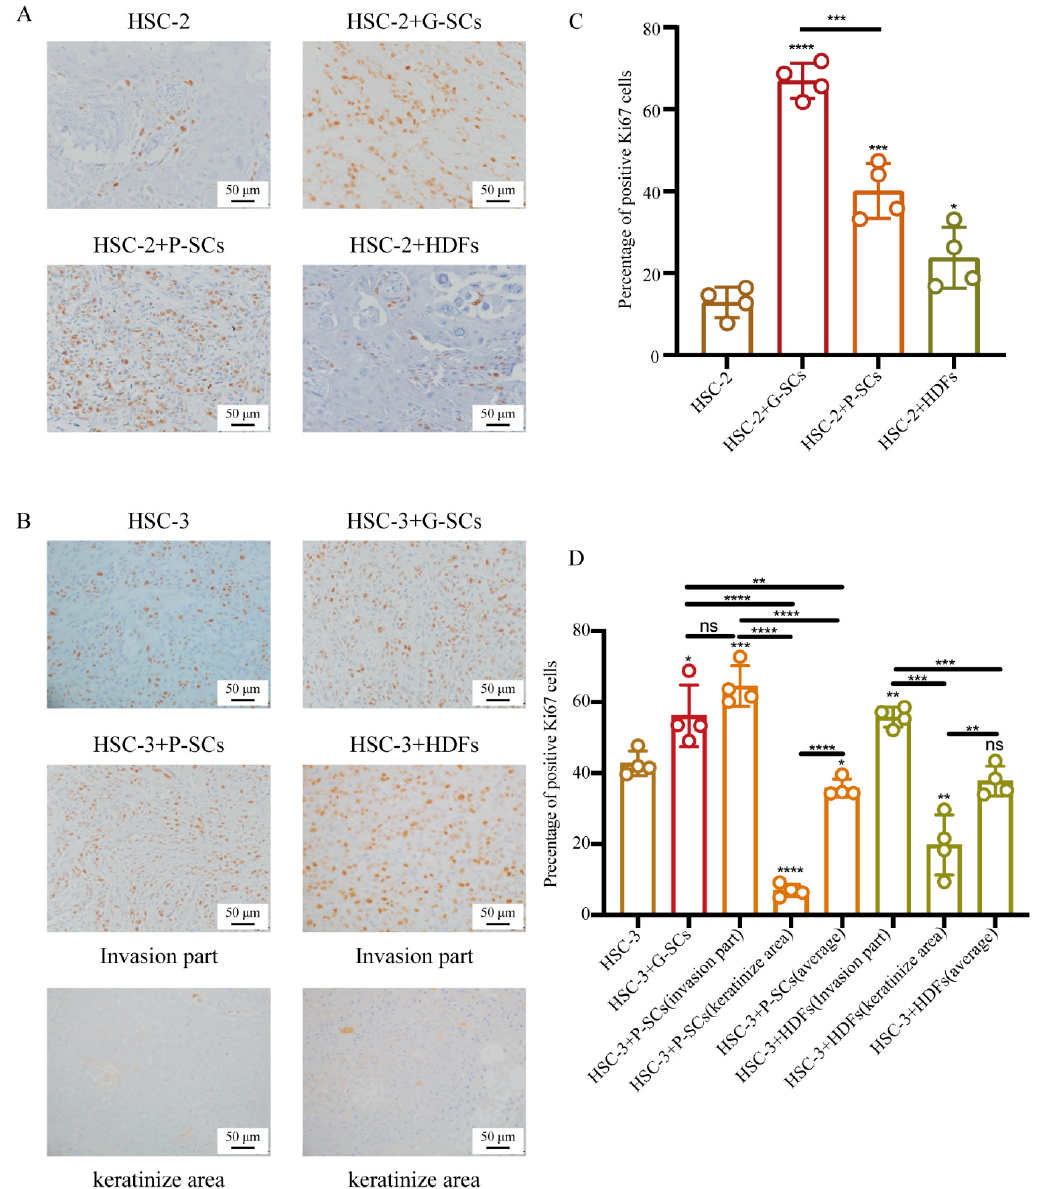
Figure 7. G-SCs and P-SCs influenced the proliferation of OSCC in vivo. ( A , B ) Ki-67 IHC staining was performed to examine the effect of G-SCs and P-SCs on the proliferation of HSC-2 ( A ) and HSC-3 ( B ) in vivo. ( C , D ) Quantification of Ki-67 positive cells in different groups of HSC-2 ( C ) and HSC-3 ( D ). Data are shown as the mean ± s.d. (s.d., standard deviation), n = 4. Each group compared with HSC-2 and HSC-3, respectively, and statistical analysis was performed by Student’s t -test, ns indicates p > 0.05, * indicates p < 0.05, ** indicates p < 0.01, *** indicates p < 0.001, **** indicates p <